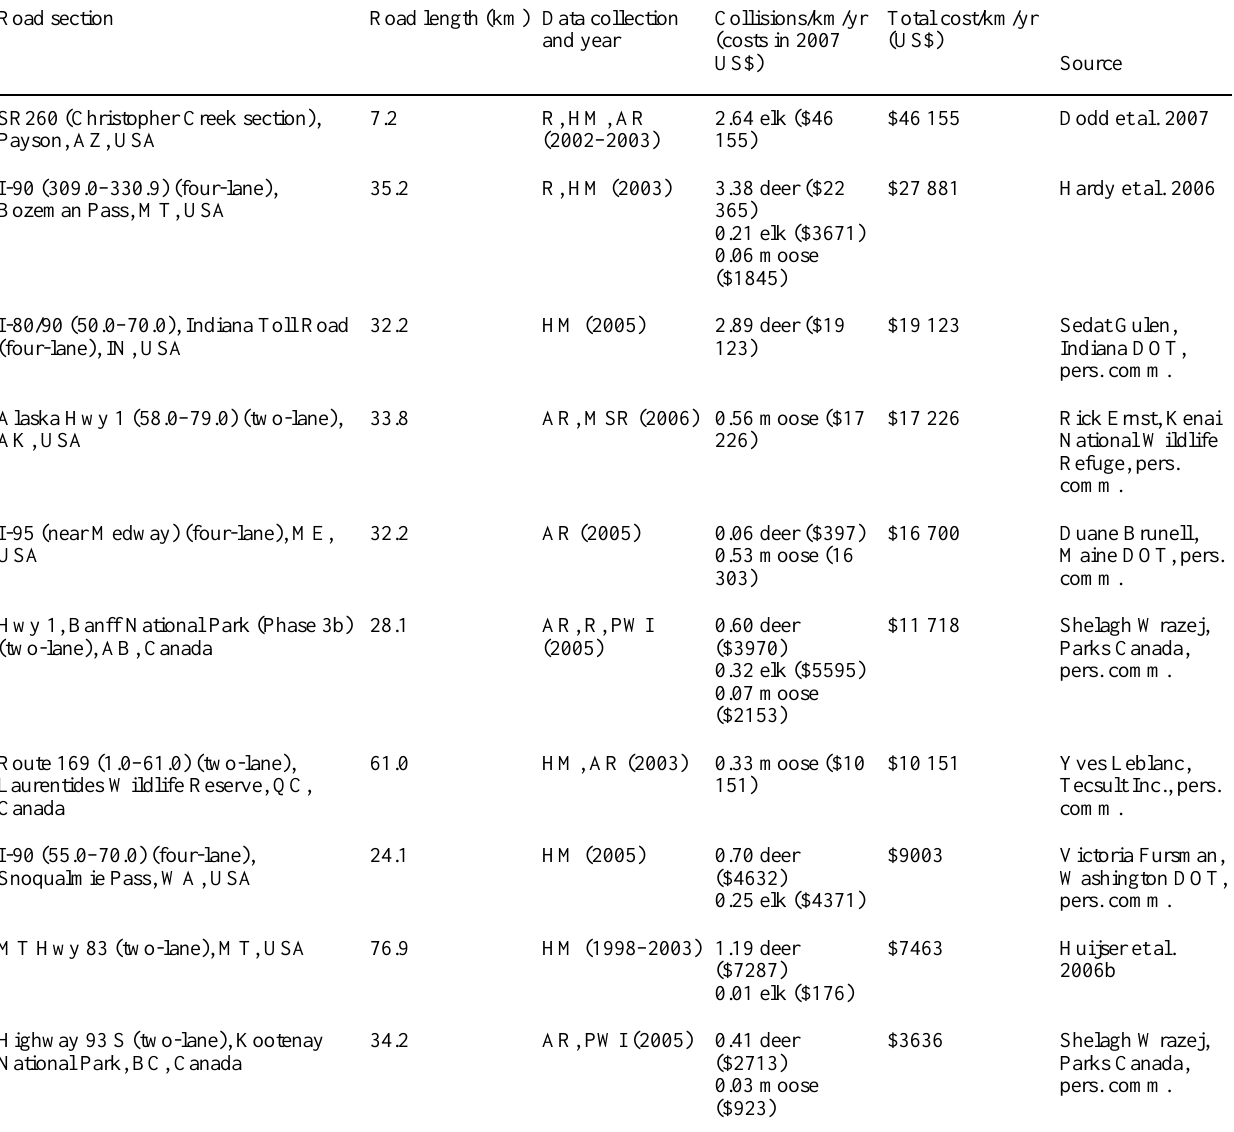
Table 5. The cost of deer–, elk–, and moose–vehicle collisions for selected road sections in the USA and Canada (all in 2007 US$). R = research project, HM = highway maintenance reports, AR = highway accident reports, PWI = park warden incident reports, MSR = meat salvage